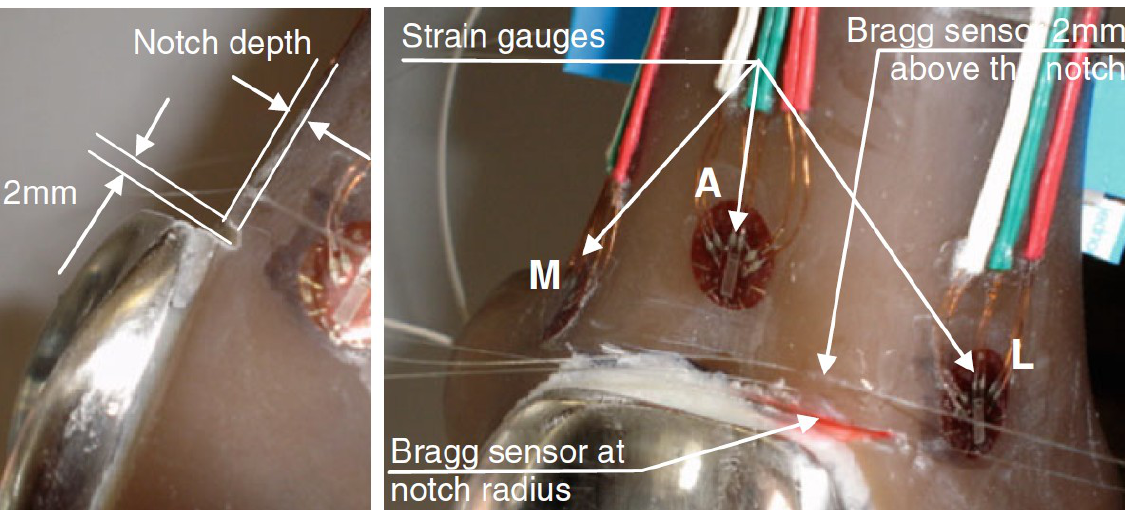
Figure 5. Images depicting the composite femur models with notch. ( left ) The notch dimensions, and ( right ) the positions of SGs (A anterior, M medial, L lateral) and FBGs